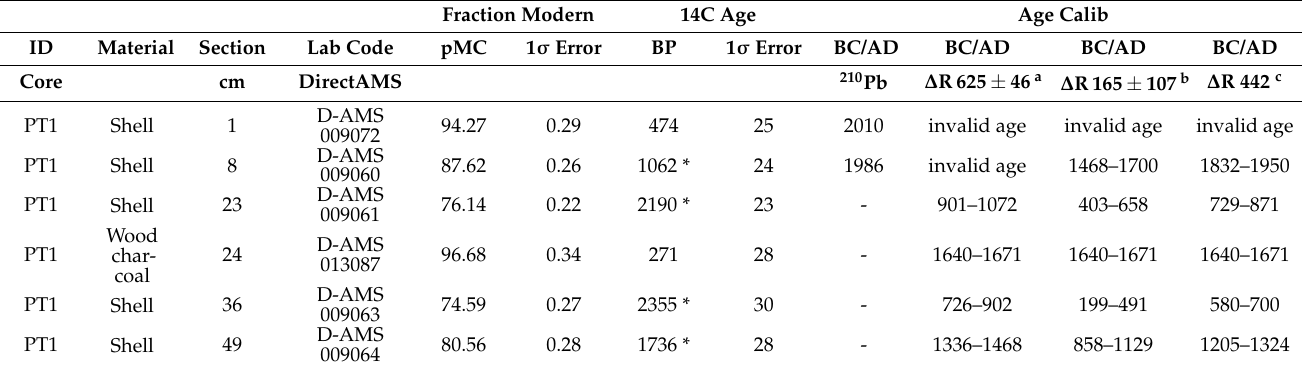
Table 1. Radiocarbon details and resulted ages on shells ( Heleobia sp.) and wood charcoal from the PT1 core. The dates obtained for the snail shells were calibrated using Calib 8.20, and the marine 20.14C curve, testing three reservoir ages (a, b and c); for wood charcoal age, it was calibrated using the Shcal20.14C curve